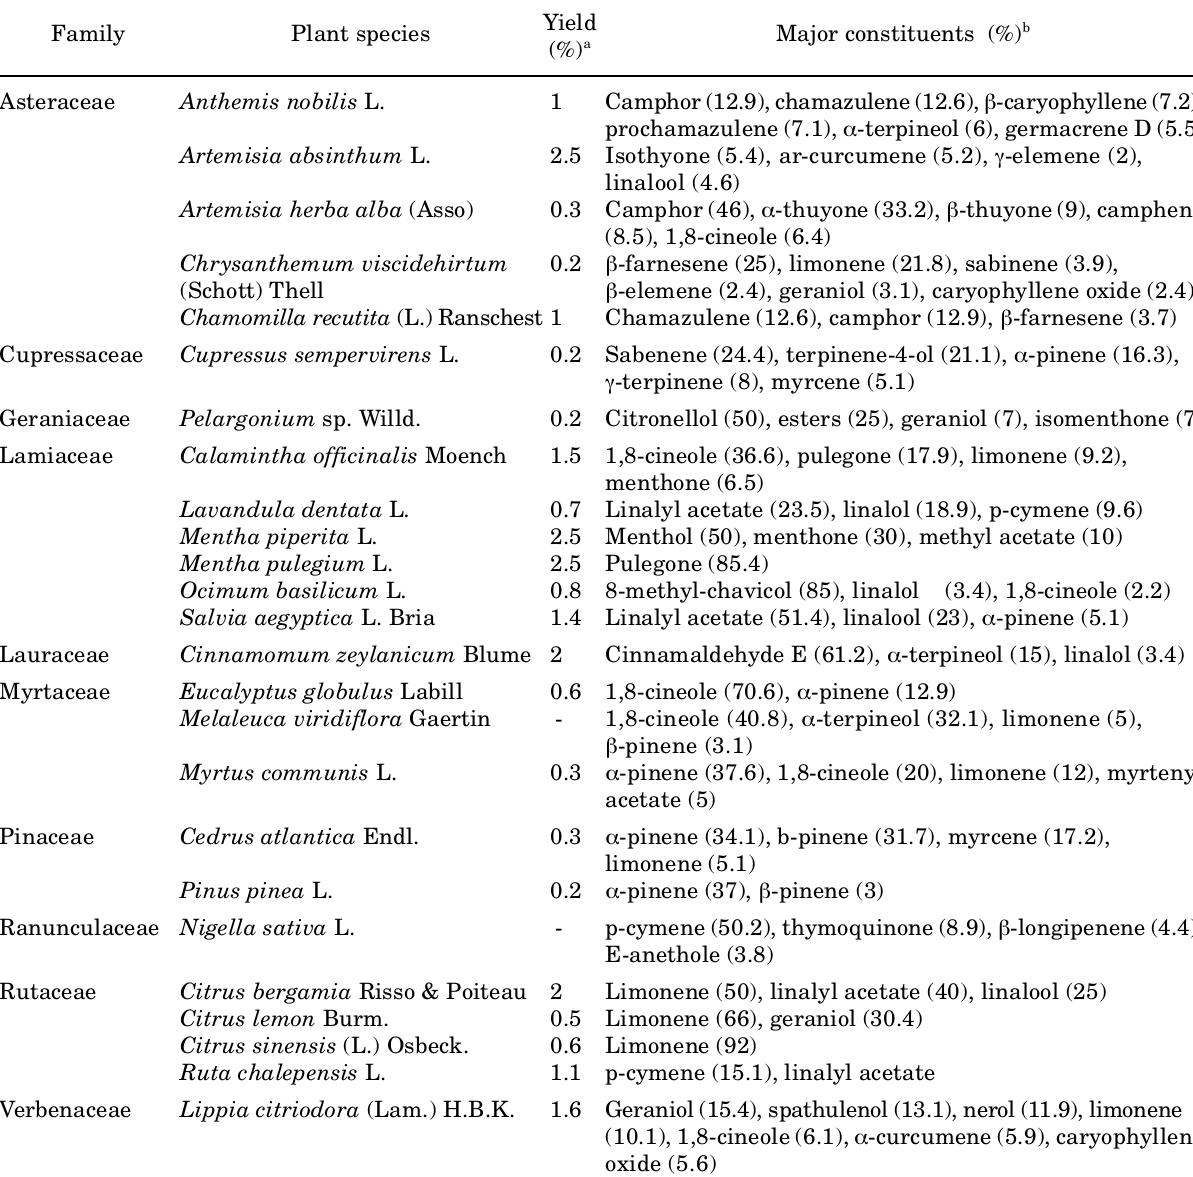
Yield Major constituents (%) b (%) a